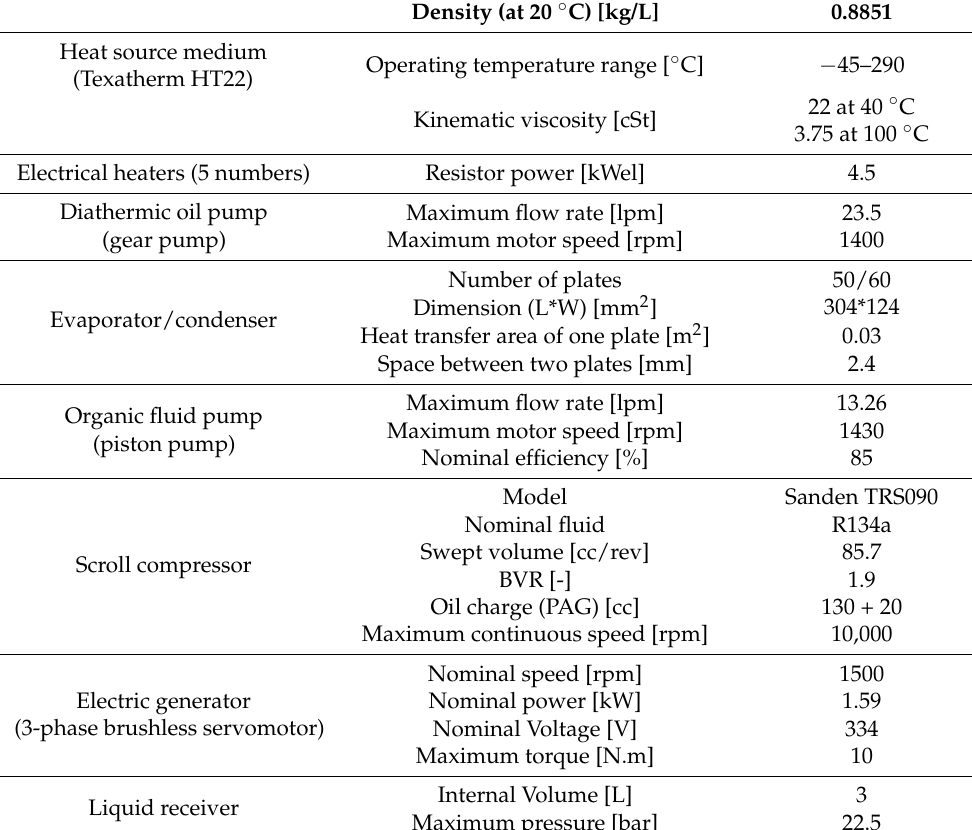
Table 1. Characteristics of main components of the ORC unit.